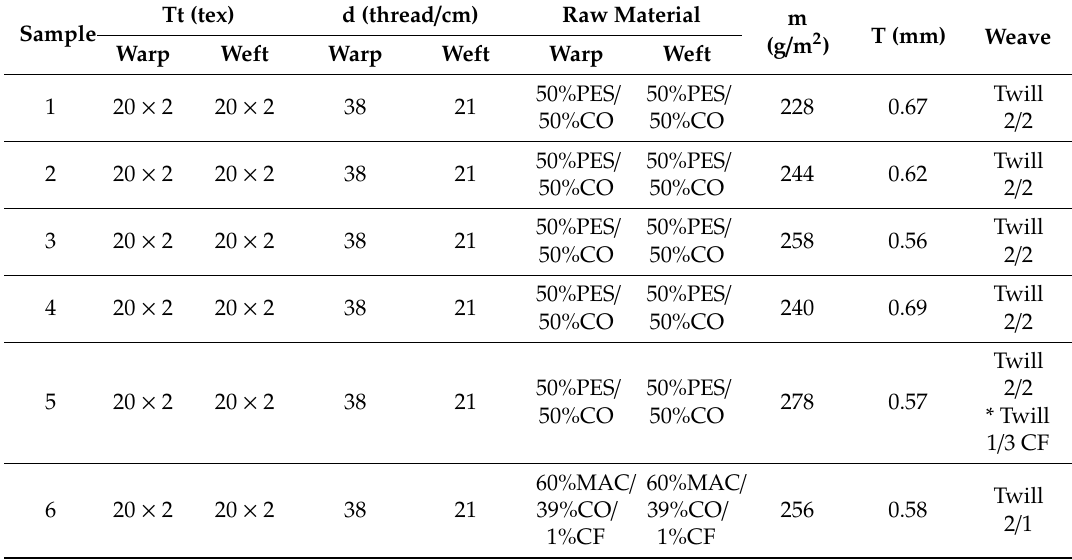
Table 1. Basic structural parameters of woven fabric samples.